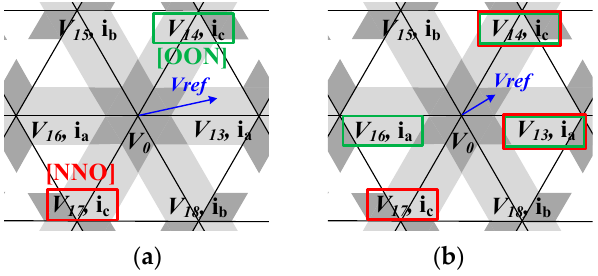
Figure 9. Duration of the reference voltage vector in CUAs. ( a ) Area 2; ( b ) Area 3.